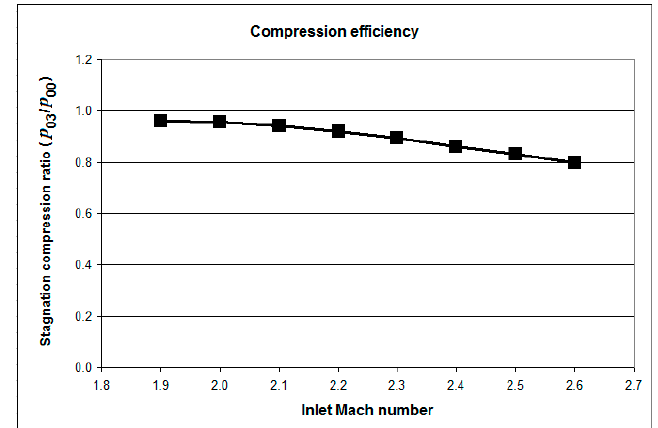
Figure 8. Compression efficiency in the set of two oblique shockwaves and single normal shockwave represented by the stagnation pressure ratio ( p 03 / p 00 ).